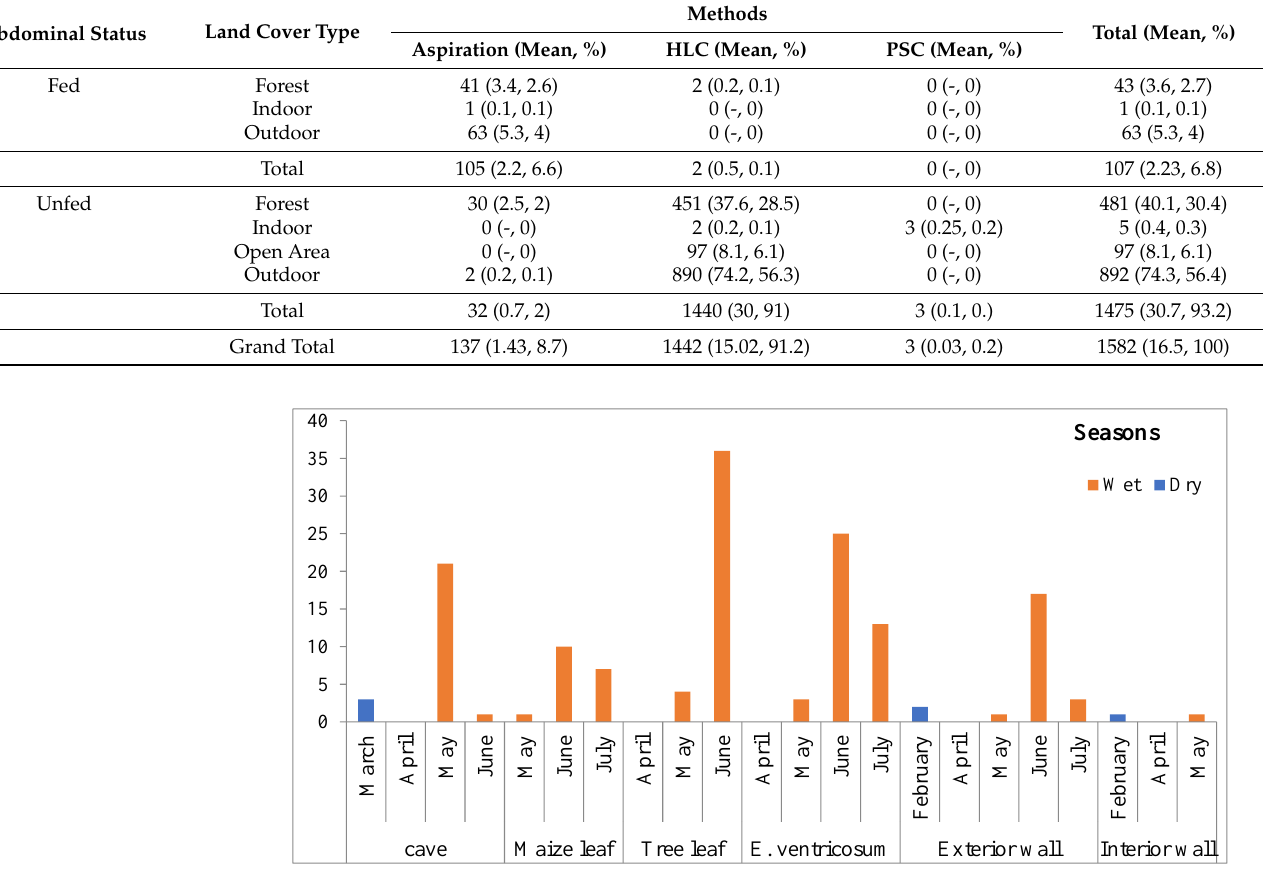
Figure 2. Ecological and seasonal distribution of mosquitoes in southwestern Ethiopia.